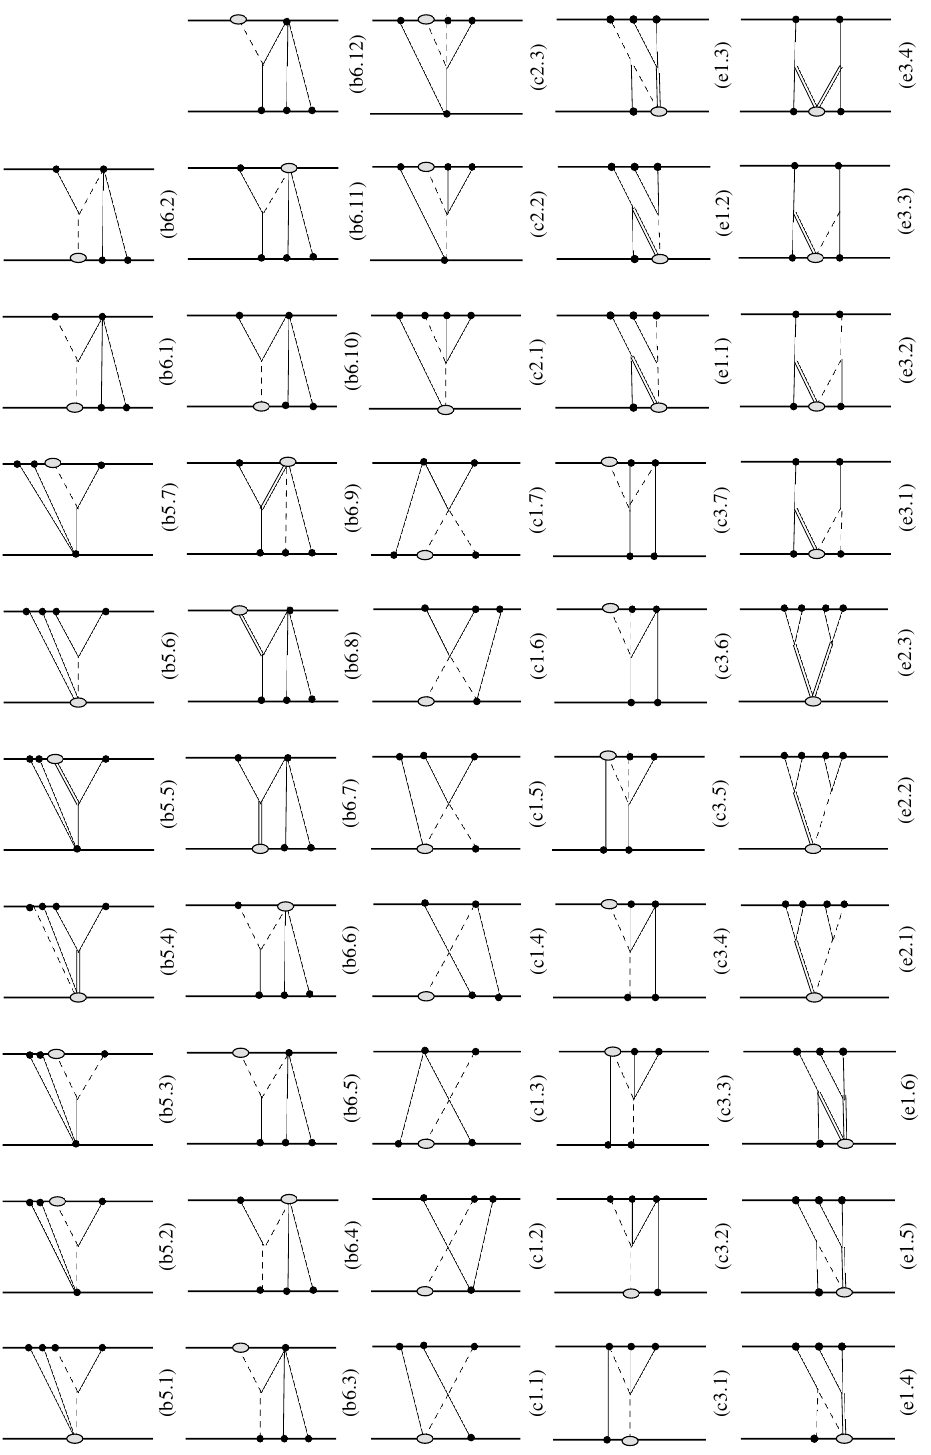
Figure 6 . Feynman graphs which contribute to the N 3 LO spin-orbit coupling at G 4 . This figure contains all graphs with topologies (b5), (b6), (c), and (e1)-(e3), of figure